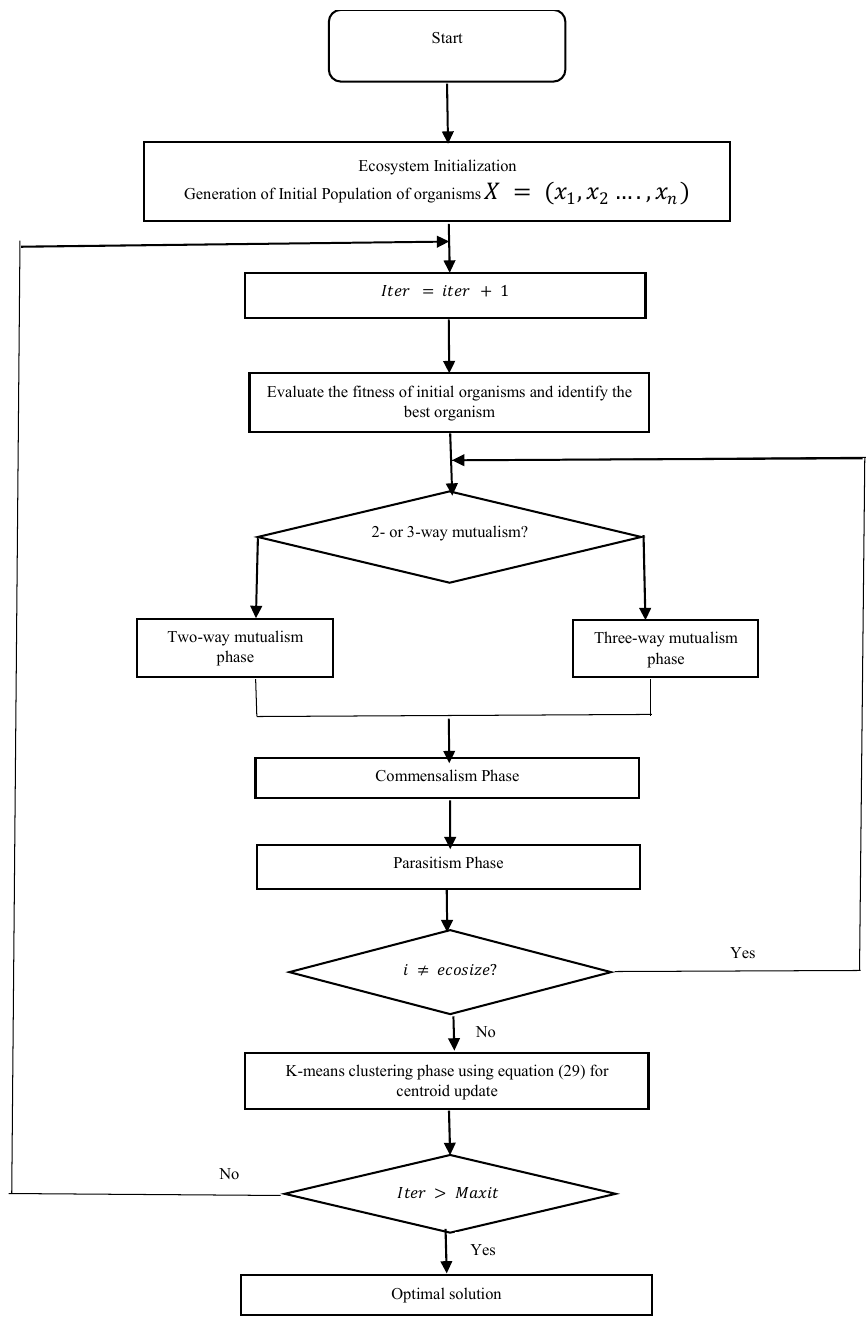
Figure 1. Flowchart for ISOSK-means clustering algorithm.